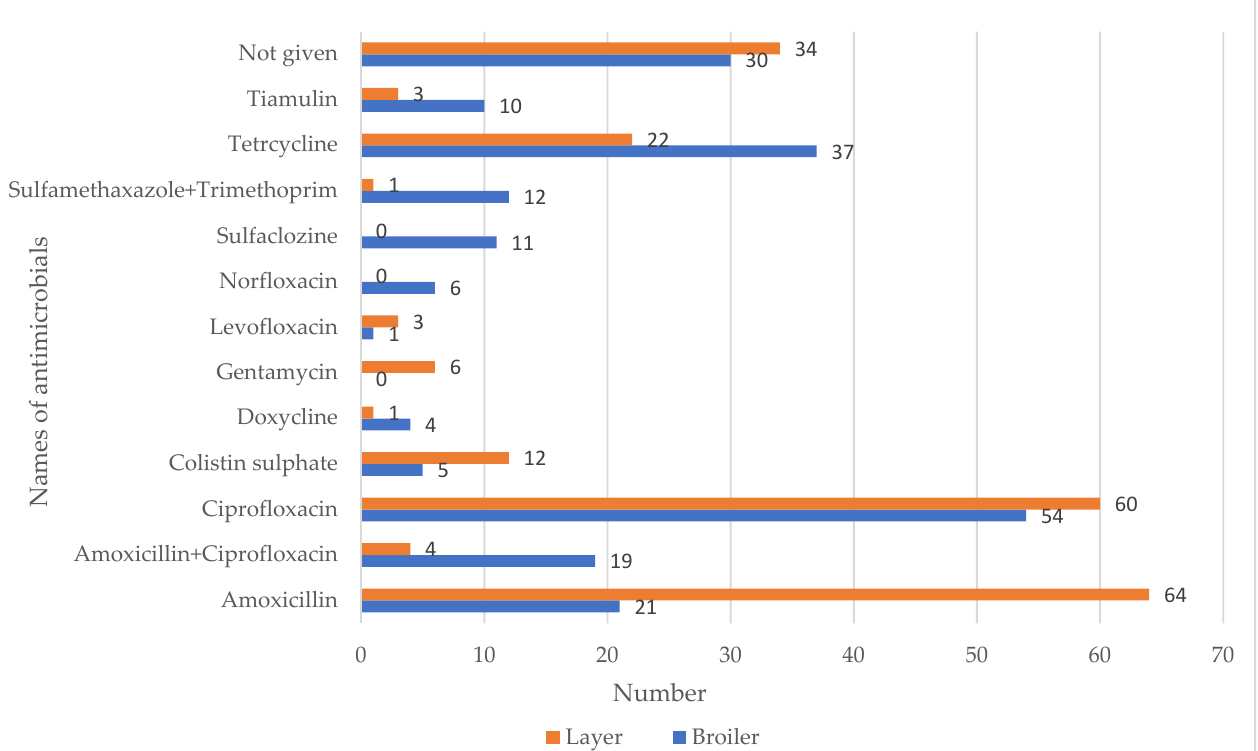
Figure 3. Use of antimicrobials on poultry farms against different diseases (disaggregated by the type of farm).